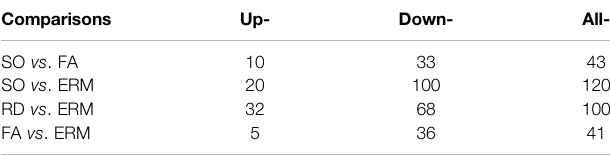
related to biological adhesion, cell adhesion, lipid metabolic process, negative regulation of response to stimulus, and negative regulation of Wnt signaling pathways ( p -value < 0.05). These proteins mainly play roles in iron binding, metal ion binding, cation binding, hyaluronic acid binding, transporter activity, and lipid transporter activity ( p -value <